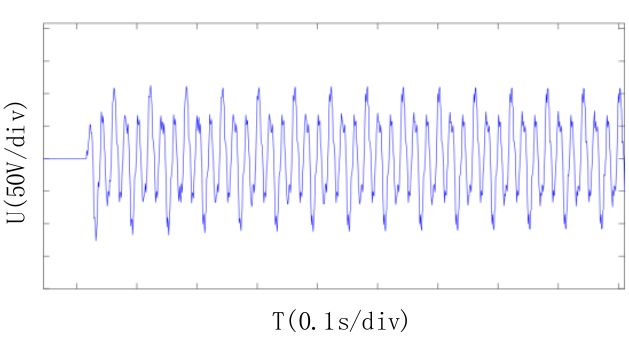
Figure 6. Time-domain waveform of the single-phase waves.